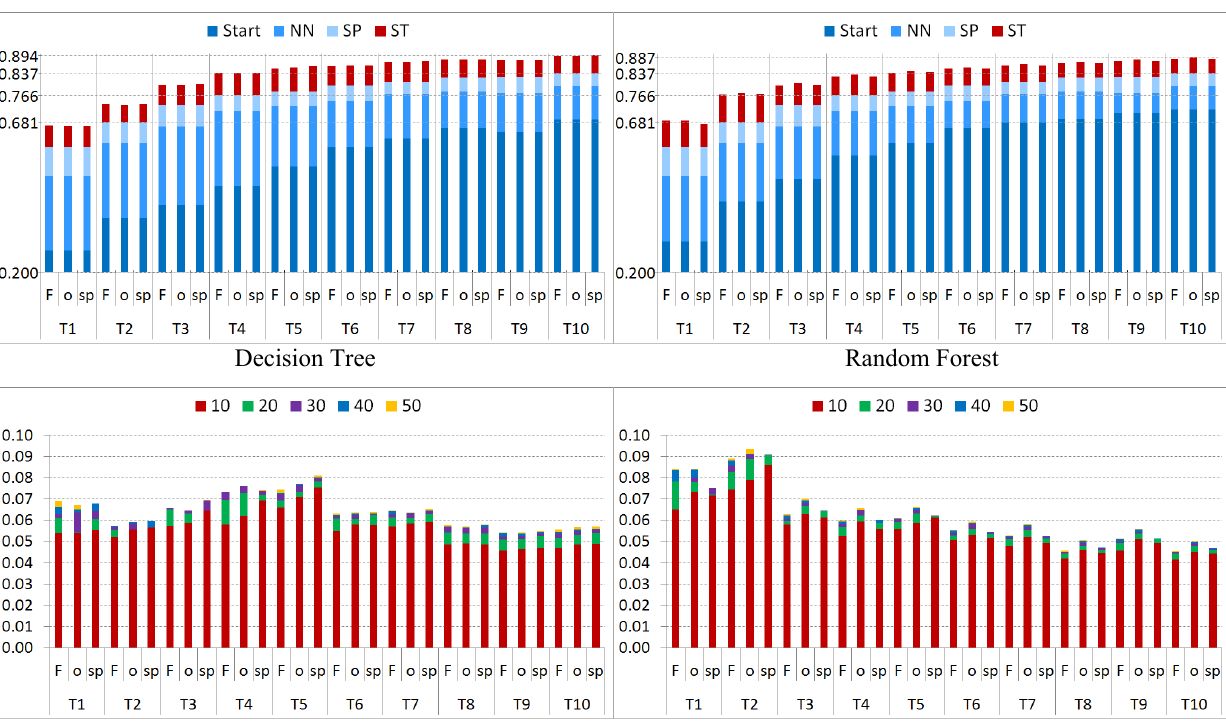
Figure 14. Top row: Classification accuracies for different training sets, SP selection methods for the unlabeled samples. Bottom row: Improvements of self-training (ST) per 10th iteration for the two base learners. The selection methods are abbreviated as F ( full ), o (NH ), and sp (NH ). o sp